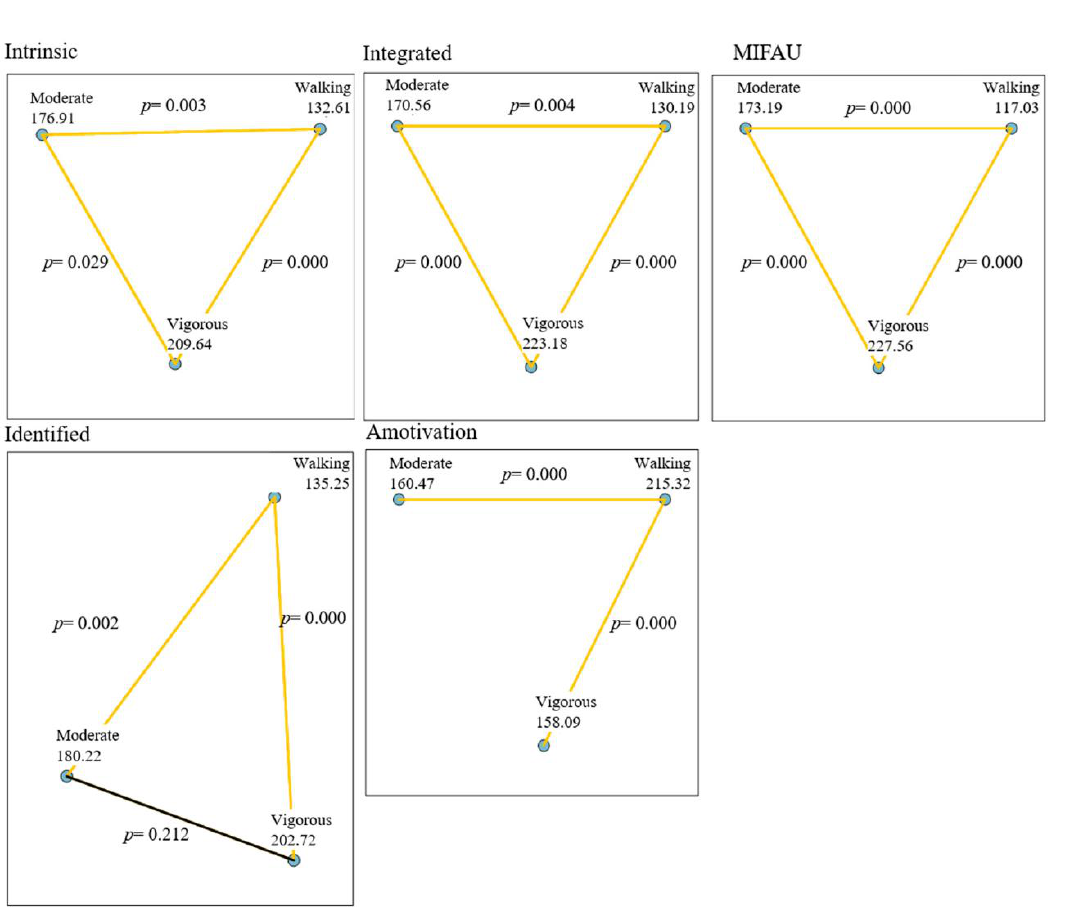
Figure 1. Multiple pairwise comparisons of the behavioural regulation in exercise variables according to the Physical Activity.